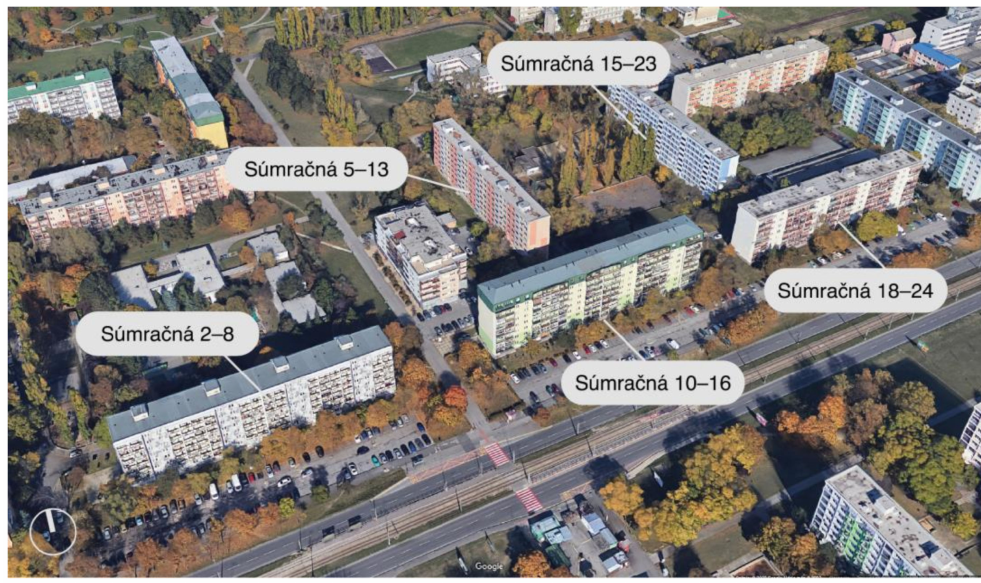
Figure 11. Ostredky housing estate, Bratislava, with marked buildings selected for the case study. Source: Edited by the authors based on CNES/Airbus, European Space Imaging, Maxar Technologies, 2022. Available at: https://www.google.com/maps/@48.1561984,17.1679487,294a,35y,12.52h,45.5 4t/data=!3m1!1e3 (accessed on 22 December